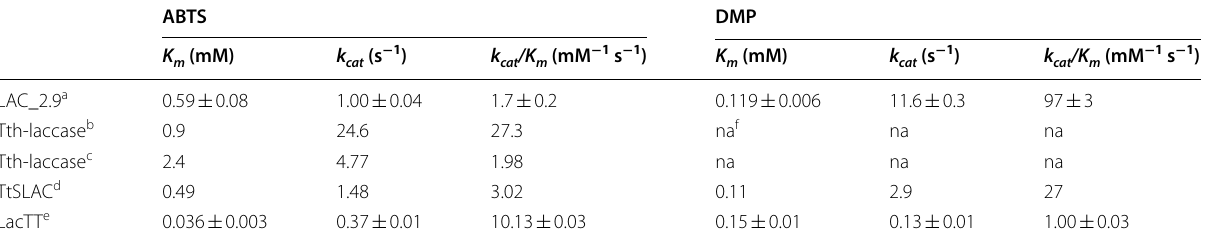
Table 1 Comparison of the steady-state kinetic parameters of LAC_2.9 with those of laccases from Thermus thermophilus